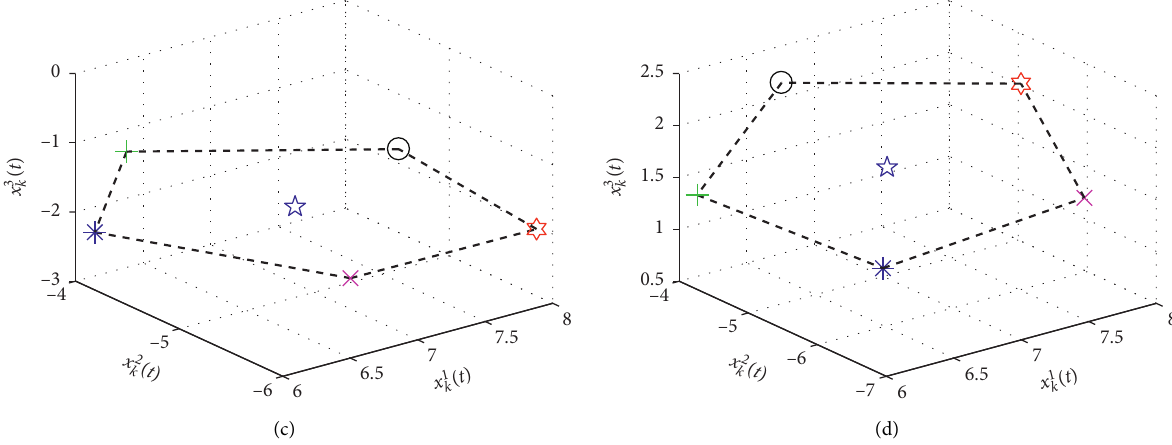
Figure 3: State snapshots of all the agents at different times: (a) t � 0s, (b) t � 8s, (c) t � 9 s, and (d) t � 10s.